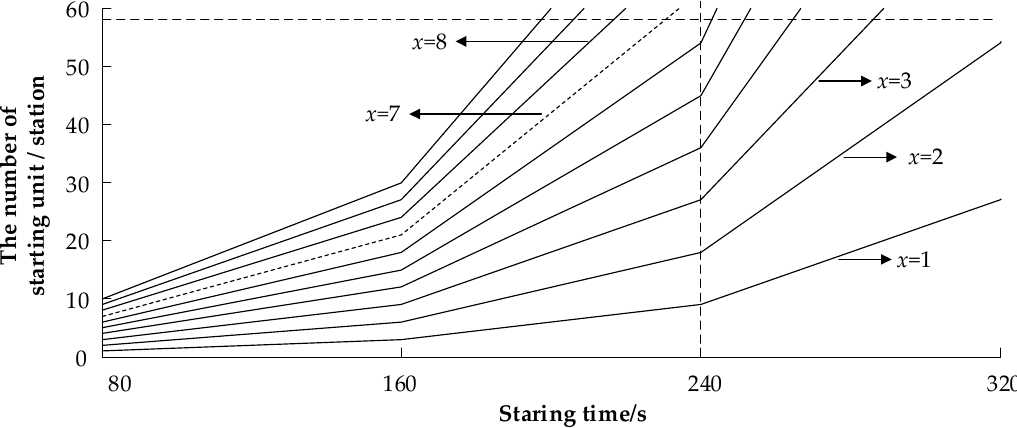
Figure 6. The number of initial configuration turbines.